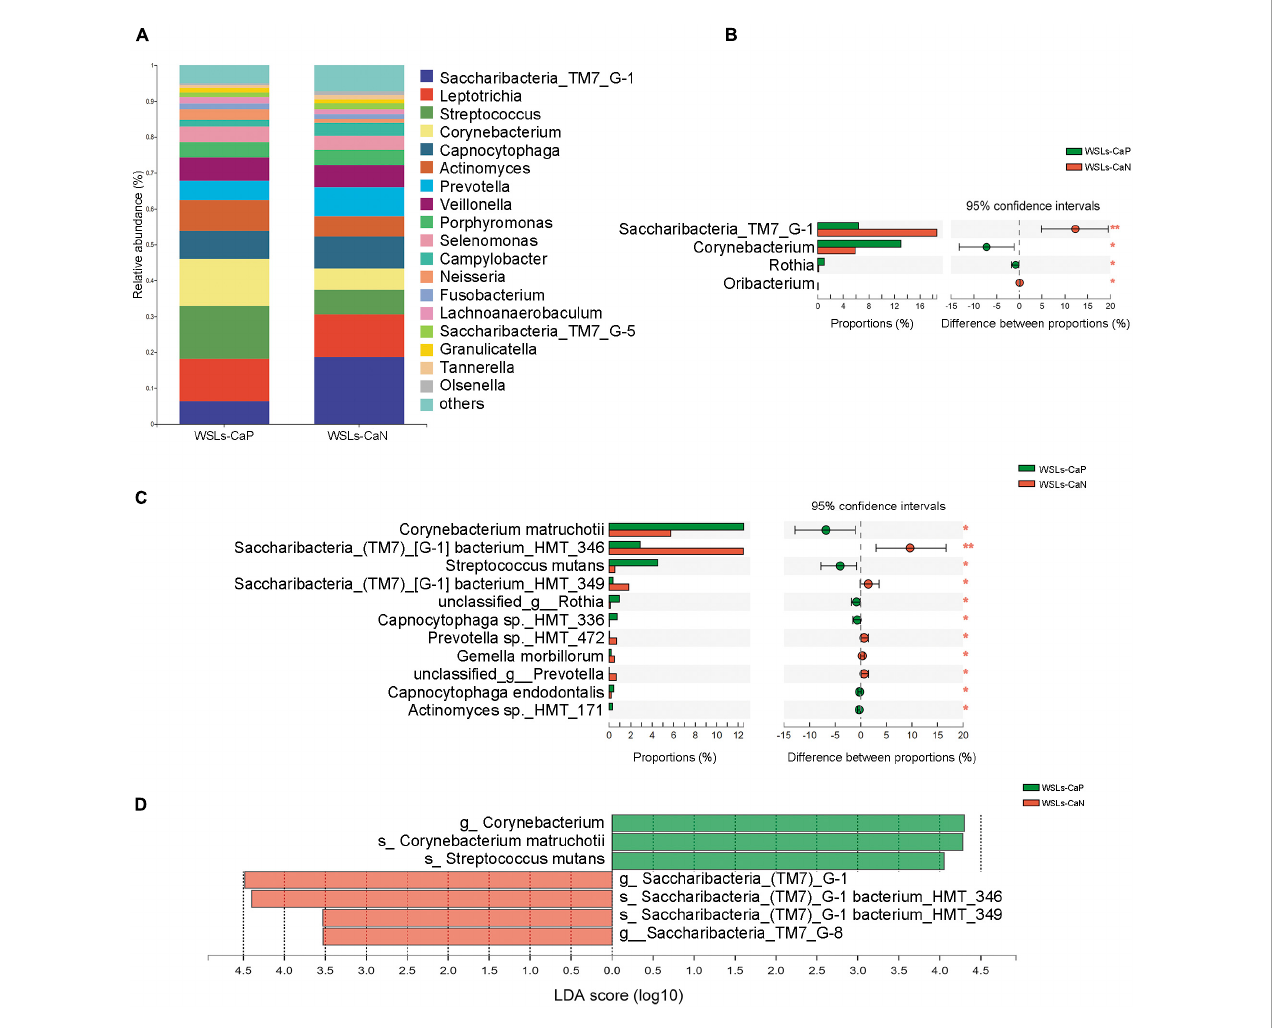
FIGURE5 Comparison of microbial composition between Candida albicans carriers and non-carriers in WSLs patients. (A) Relative abundances of the core genera (relative abundance > 1.0%) in WSLs-CaP and WSLs-CaN groups. “Others” represented all the genera less than 1%. (B) Significantly differentiated genera between WSLs-CaP and WSLs-CaN groups. Saccharibacteria_TM7_G-1 was much enriched in plaque without C. albicans infection, while Corynebacterium , Rothia and Oribacterium were enriched in C. albicans positive group. (C) Significantly different species examined between WSLs-CaP and WSLs-CaN group were displayed. In C. albicans carriers, Corynebacterium matruchotii and Streptococcus mutans significantly enriched, whereas several species such as Saccharibacteria_TM7_G-1 bacterium_HMT_346 and Saccharibacteria_TM7_G-1 bacterium_HMT_349 significantly enriched